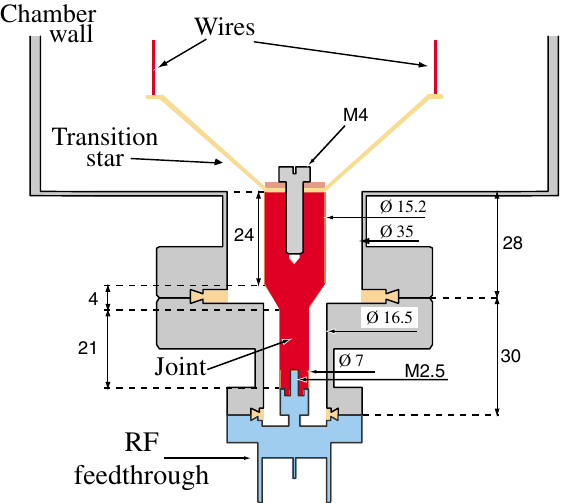
FIG. 7. (Color) Characteristic impedance along the chamber before (orange segments) and after (black triangles) the im- provements described in Sec. II. Eventually, the impedance along the line is close to 50 (cid:3) everywhere except for the unavoidable residual mismatches after the feedthroughs (tran- sition from the feedthroughs to the six wire structure), which do not significantly affect the transmission coefficient.